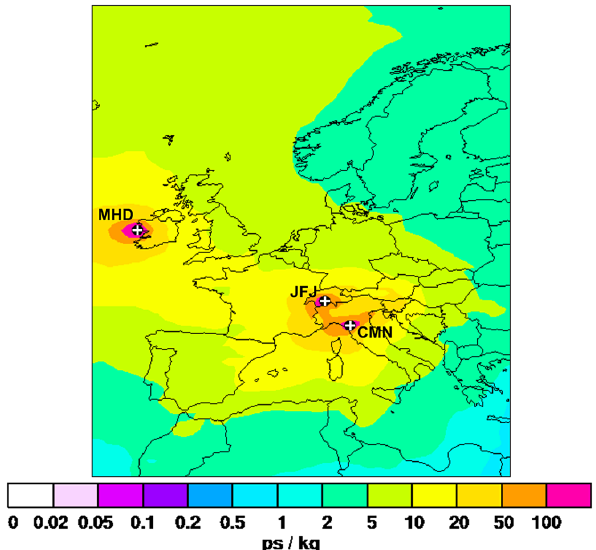
Figure 1. Footprint emission sensitivity in picoseconds per kilo- gram (pskg − 1 ) obtained from FLEXPART 20-day backward cal- culations averaged over all model calculations for three stations (CMN, JFJ, MHD) over 2 years (January 2008–December 2009). Measurement sites are marked with a white cross on black